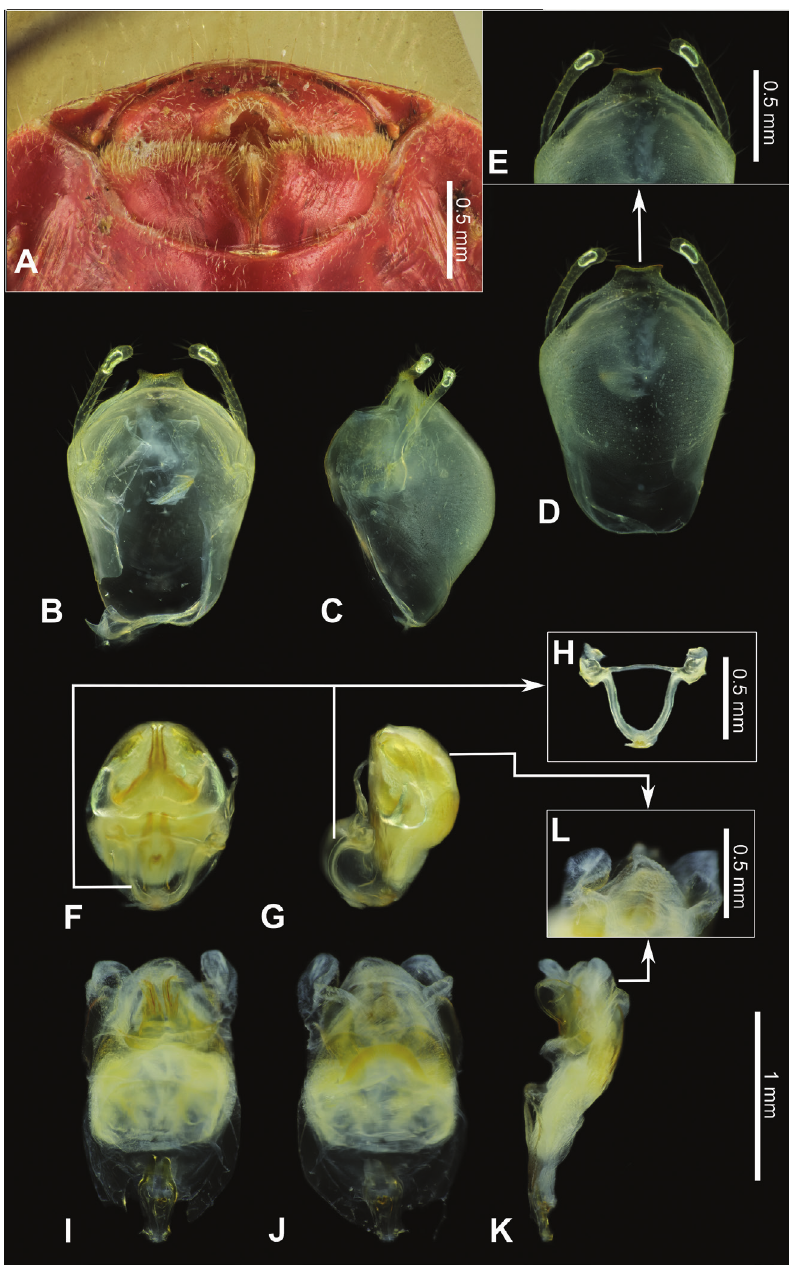
Figure 15. Biasticus taynguyenensis Ha, Truong & Ishikawa, sp. nov. A female genitalia in ventral view, holotype, ♀ , HNL2018-073 B–L male genitalia, paratype, ♂ , TXL2016-545 B–E pygophore with para- meres B dorsal view C lateral view D ventral view E apical portion of pygophore, showing median process (mpp) and parameres F–L phallus F dorsal view G lateral view H articulatory apparatus (aa) I aedeagus with endosoma semi-everted dorsal view J aedeagus with endosoma semi-everted, ventral view K aedeagus with endosoma semi-everted, lateral view L distal dorsal lobe of endosoma